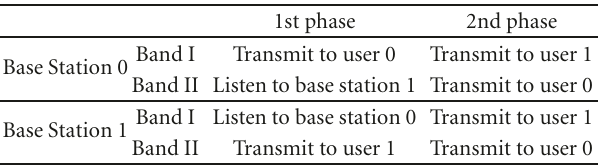
Table 1: Proposed CFR protocol, for the pair of base stations num- bers 0 and 1, operating on OFDM bands I and